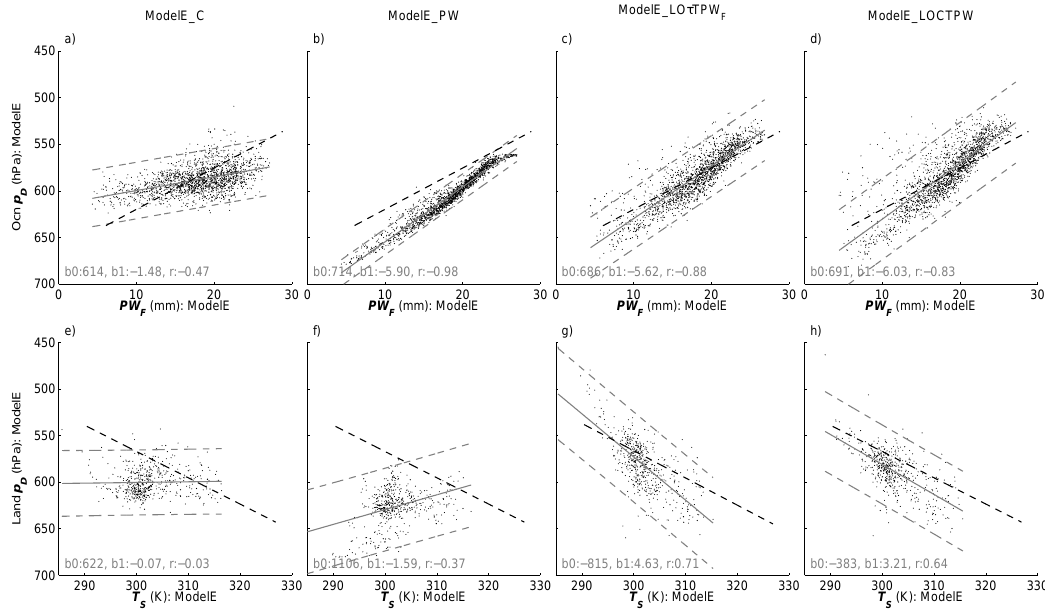
Fig. 13. Approximated p D (height of peak HDO sensitivity) as a function of PW F over the ocean (top) and T S over land (bottom) for four representative categorizations. Grey dashed lines show the 95% prediction intervals. Black dashed lines show the corresponding linear fits from TES observations in Fig. 4b and